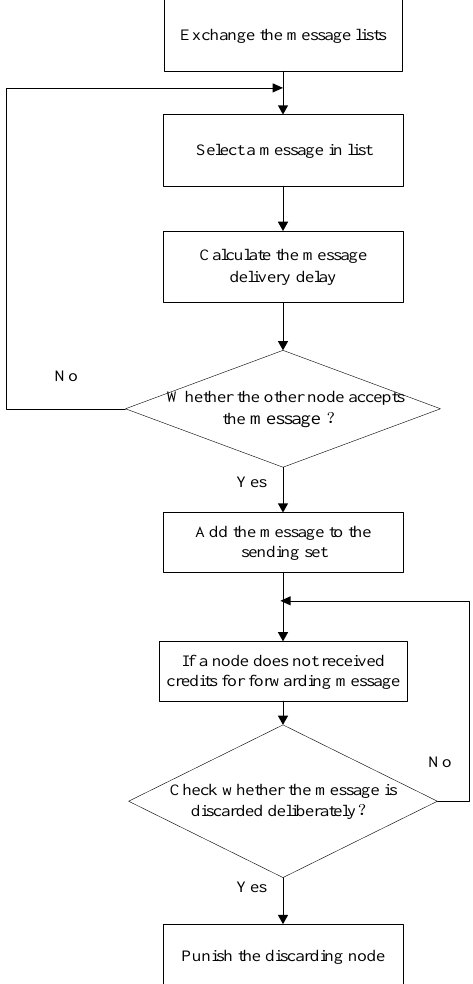
Figure 3. CBCAIS overview.